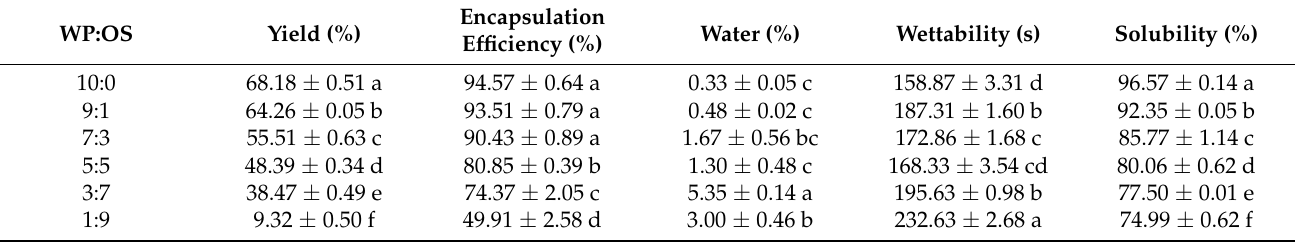
Table 2. Yield, encapsulation efficiency, water, wettability, and solubility of WP-OS-capsaicin micro- capsules a,b